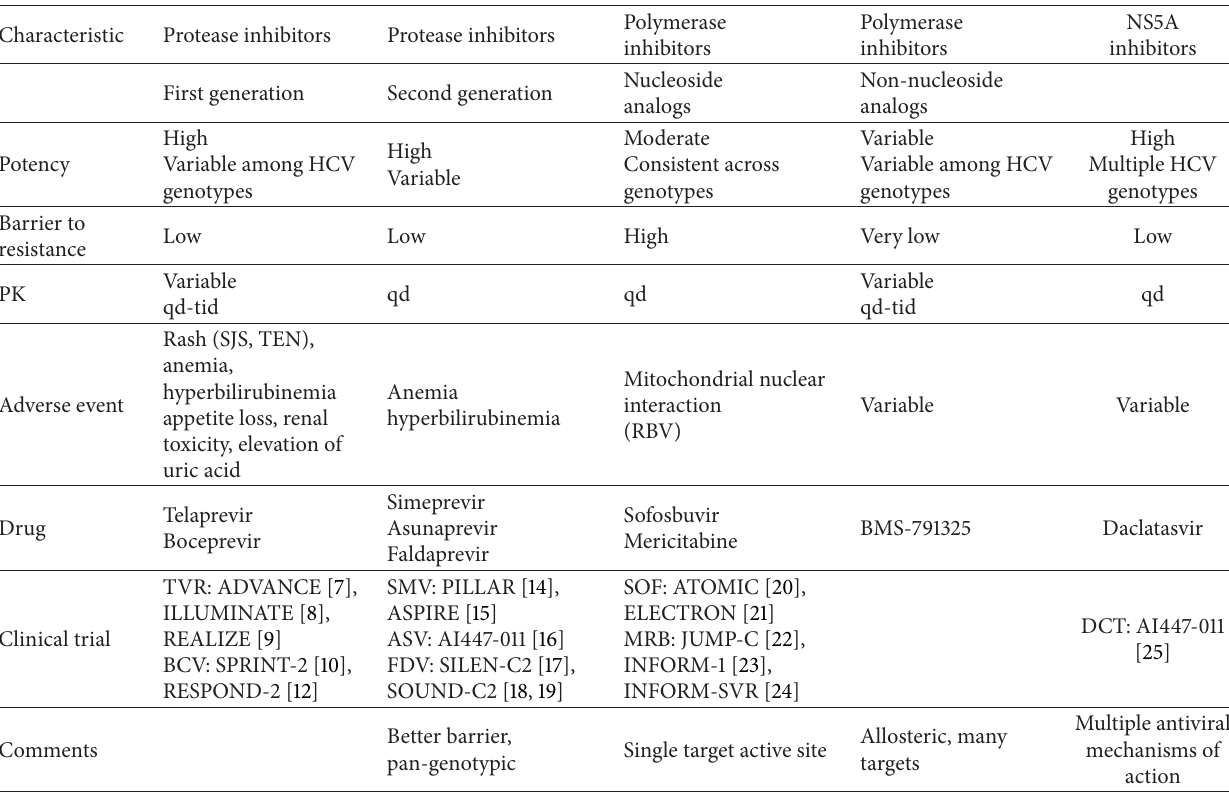
Table 1: Characteristics of HCV direct-acting antiviral classes.